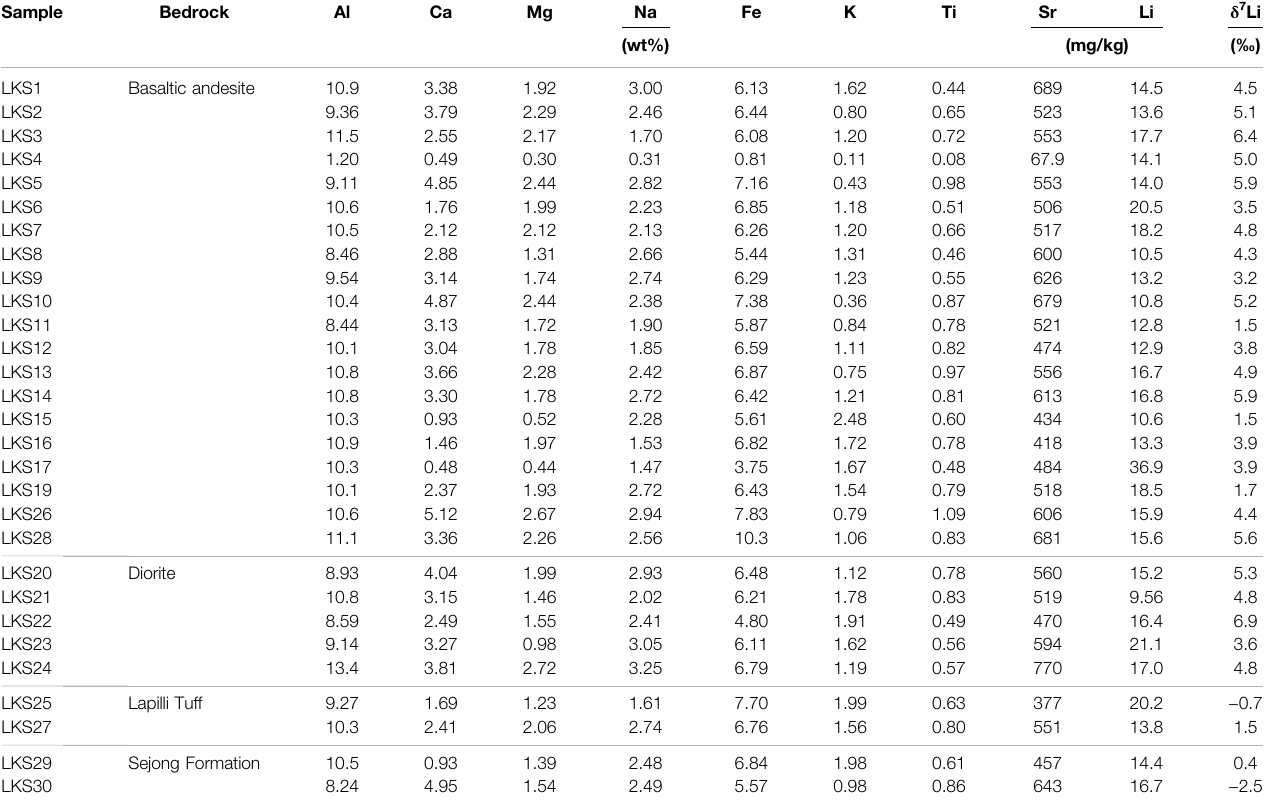
TABLE 3 | Elemental and isotopic compositions for soils.